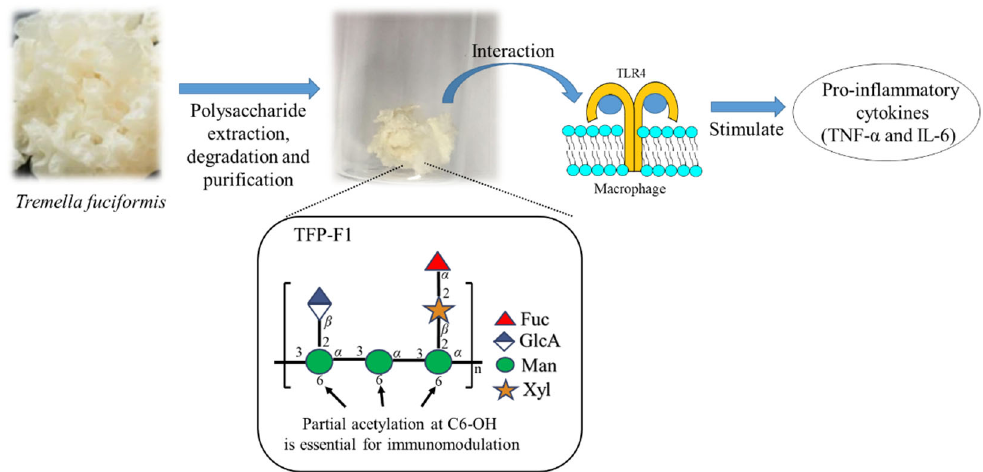
Figure 6. Purification of a water ‐ soluble bioactive polysaccharide TFP ‐ F1 from T. fuciformis induced the production of pro ‐ inflammatory cytokines through interaction with TLR4. The O ‐ acetyl groups at C ‐ 6 in mannose residues were essential for immunomodulation.